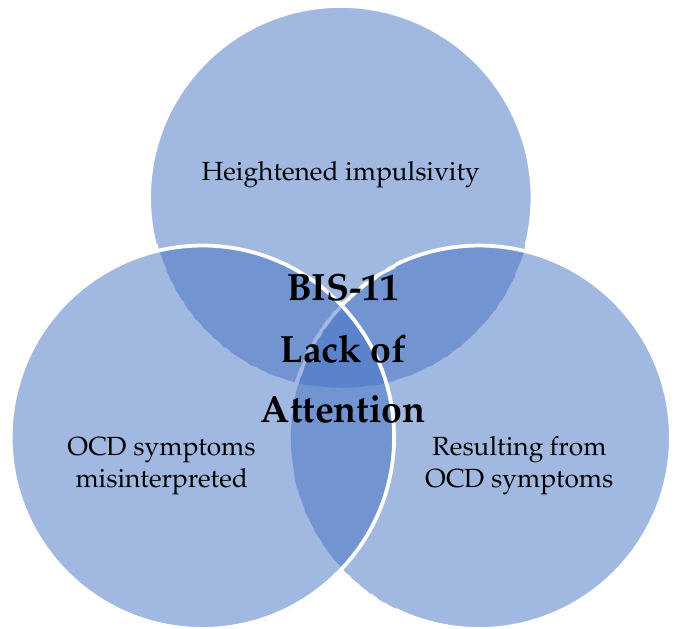
Figure 1. Conceivable explanatory model for a self-reported lack of attention in the BIS-11 question- naire in patients with OCD.